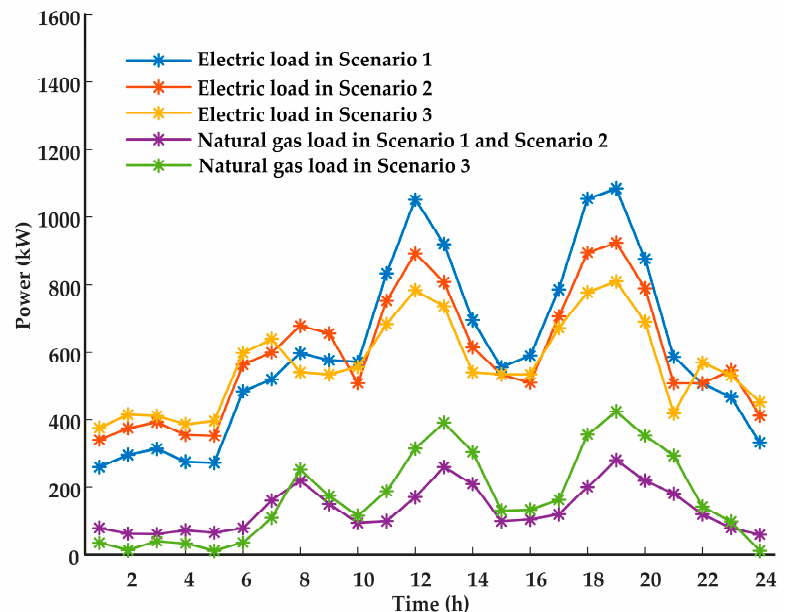
Figure 6. Electricity and natural gas loads of users in different scenarios.